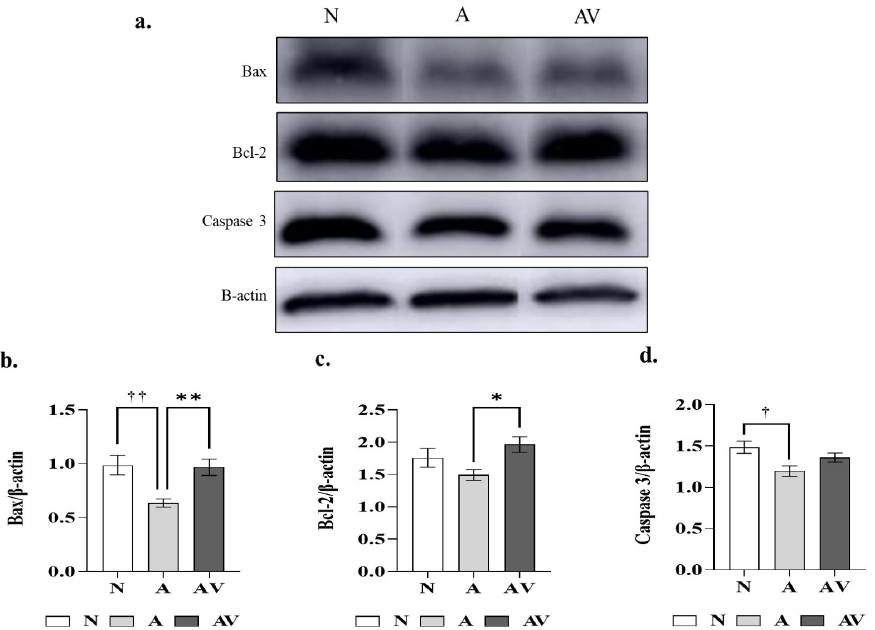
Figure 5. Apoptosis-related proteins in ApoE4-KI mice after auditory and audiovisual stimulation.